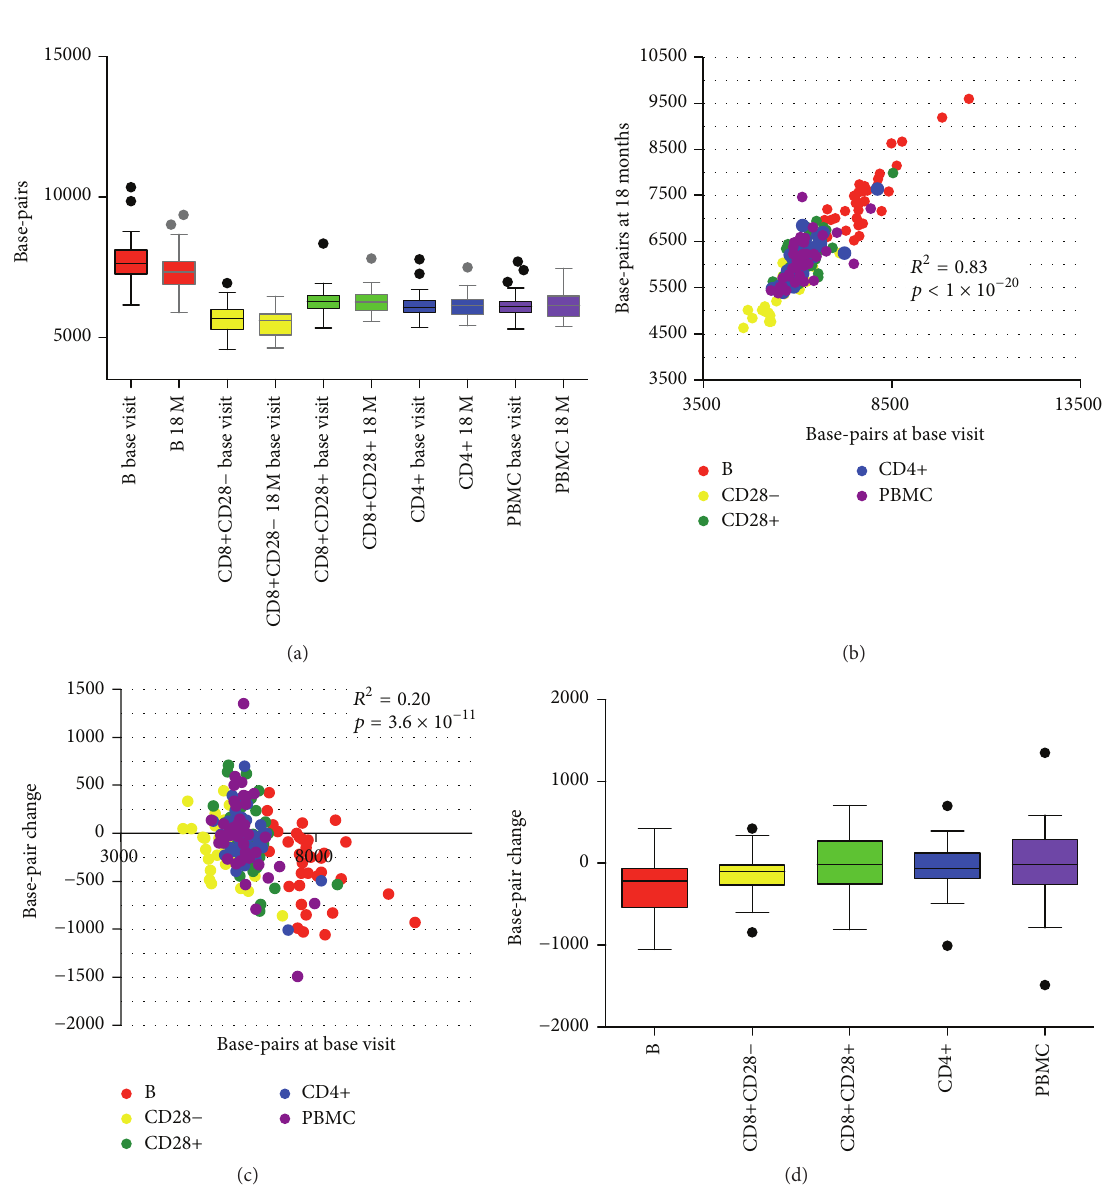
Figure 1: Telomere length in sorted cells and PBMCs. Box and whisker plots display interquartile range, median values, and maximum and minimum values. Telomere length is expressed as basepairs as described earlier [19]. (a) Telomere length in B cells, CD4+, CD8+CD28+, and CD8+CD28 − T cells, and PBMCs at base visit and 18 month visit. (b) Telomere length of the base visit and that of 18-month visit from the same cell type of the same individual are highly correlated. The graph includes telomere length from PBMC, CD4+, CD8+CD28+, and CD8+CD28 − T cells and B cells from 39 subjects. (c) Telomere length change from base visit to 18 months is negatively correlated with telomere length at base visit. (d) Telomere length change from base visit to 18 months in total PBMC, CD4+, CD8+CD28+, and CD8+CD28 − T cells and B cells. 𝑁 = 39 for each cell